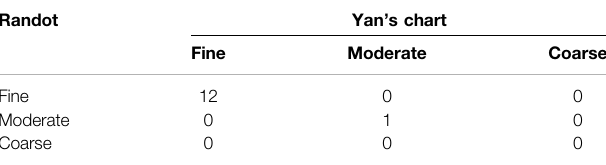
TABLE 4 | The results of 13 stereotest from 12 subjects examined by Randot and Yan ’ s Charts (0.4